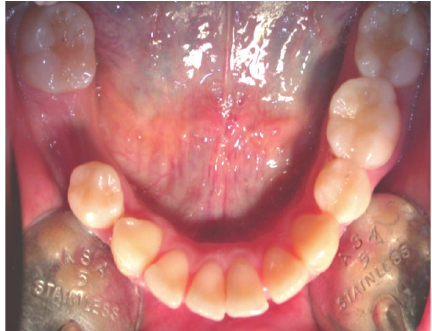
Figure 4: Occlusal